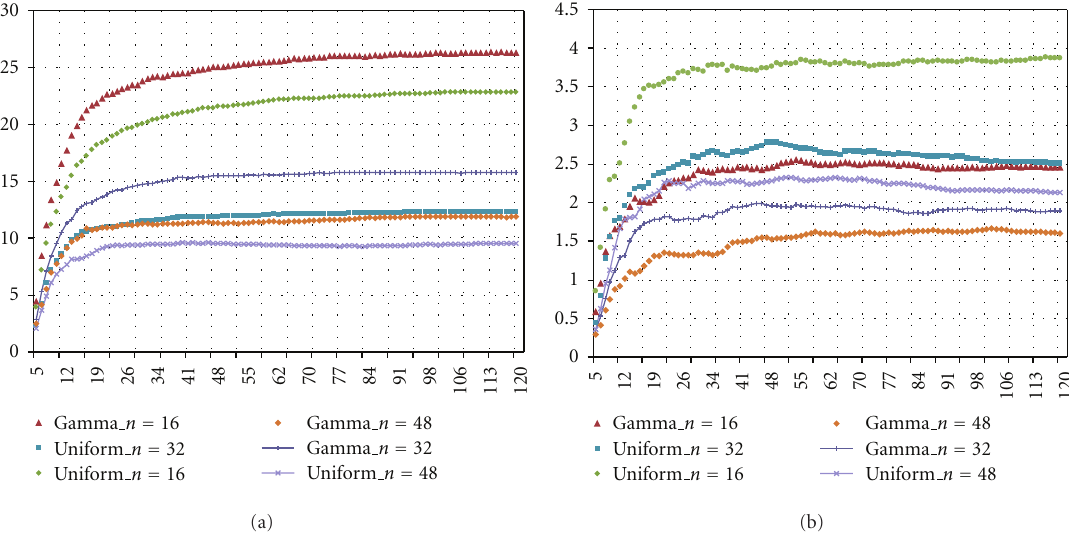
Figure 8: Transmission probability ( τ i ) for both video and voice class. Although the trends for these classes are opposite each other (in voice class (a) Uniform PDF has always lower τ i than Gamma while in video class (b) trends are reverse), but this is not a contradiction. As will be explained later both these plots vote to superiority of Gamma PDF.